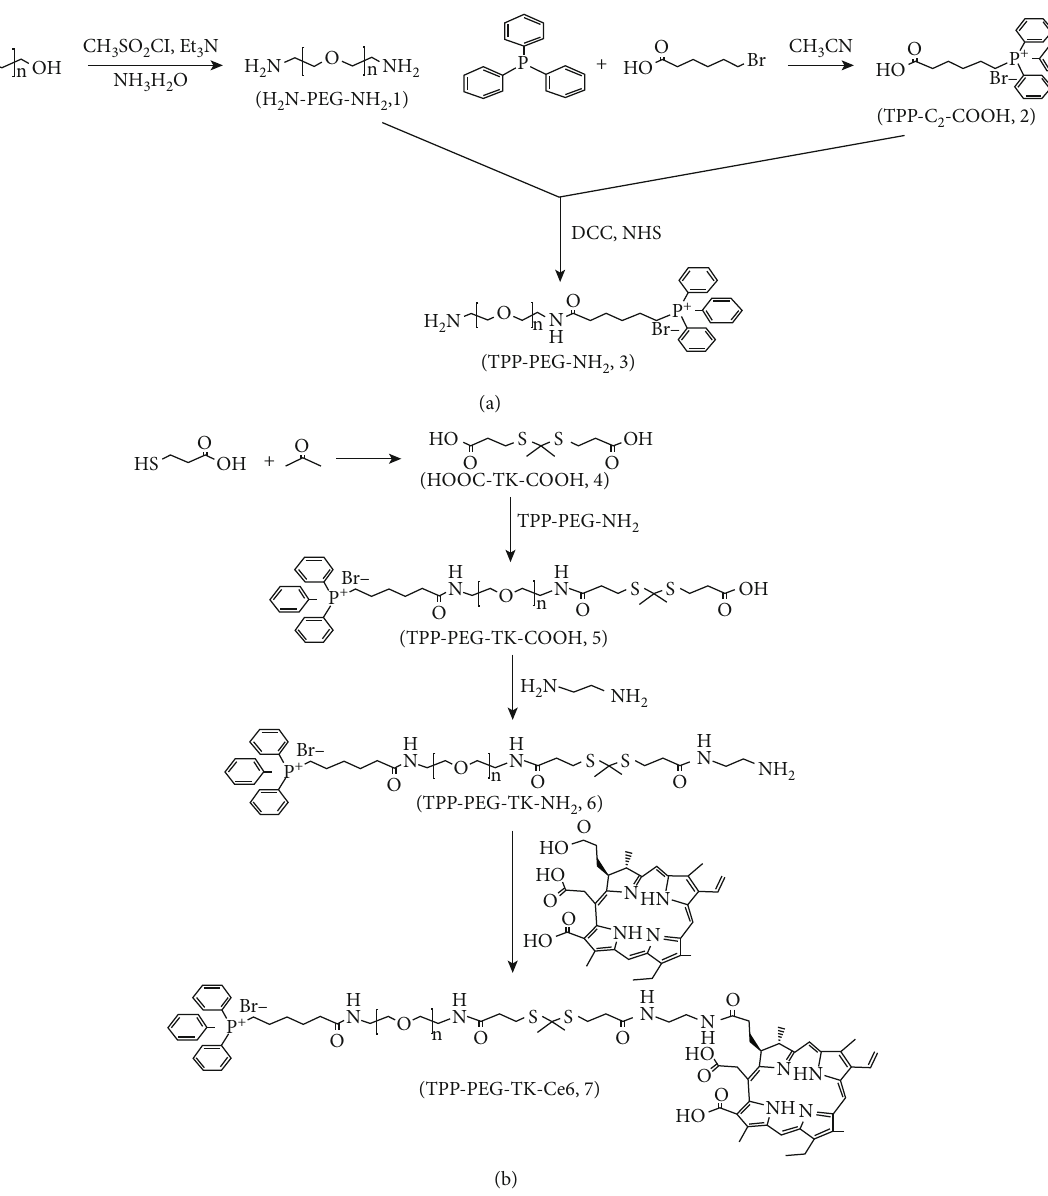
Figure 1: The synthesis pathway of TPP-PEG-NH